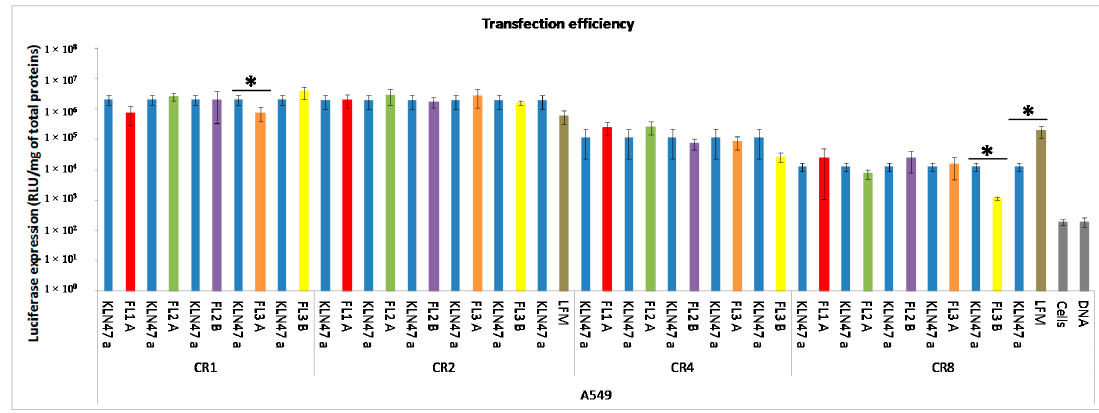
Figure 3. Cont. Figure 3.